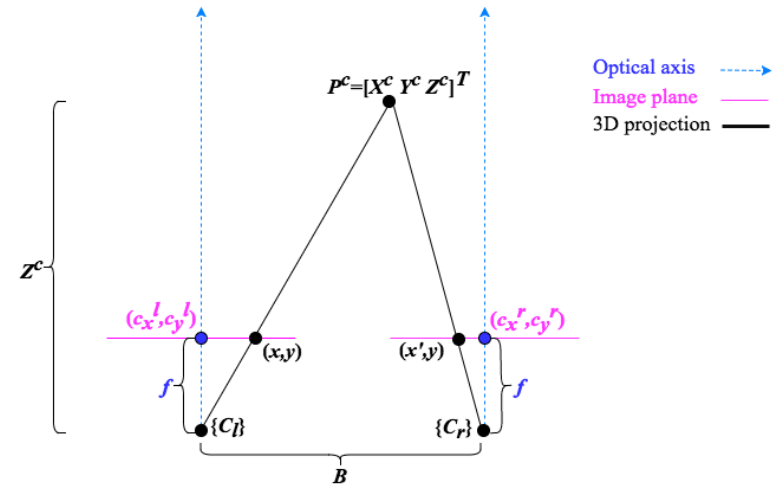
Figure 1. Frontal parallel stereo camera configuration for depth